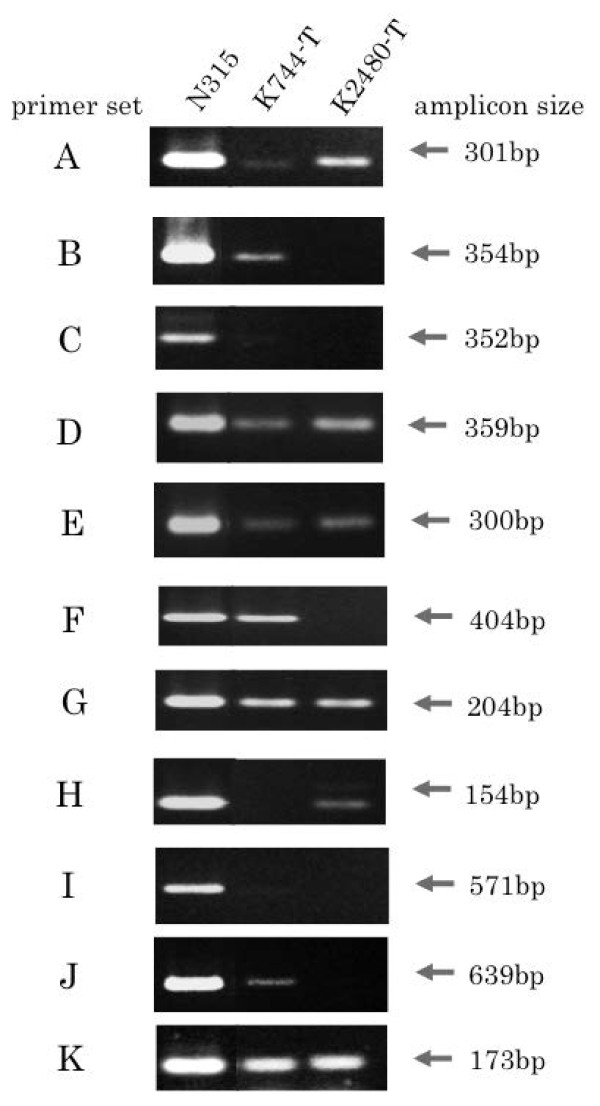
PCR products of theblaZgene. The primer sets in alphabetical order correspond with that in Table 2. Agarose gel electrophoresis was carried out as described in the legend to Figure 2. Only a part of the electrophoretogram is shown. Arrow and bp, the amplicon size; N315, K744-T and K2480-T were the source of the template DNA.